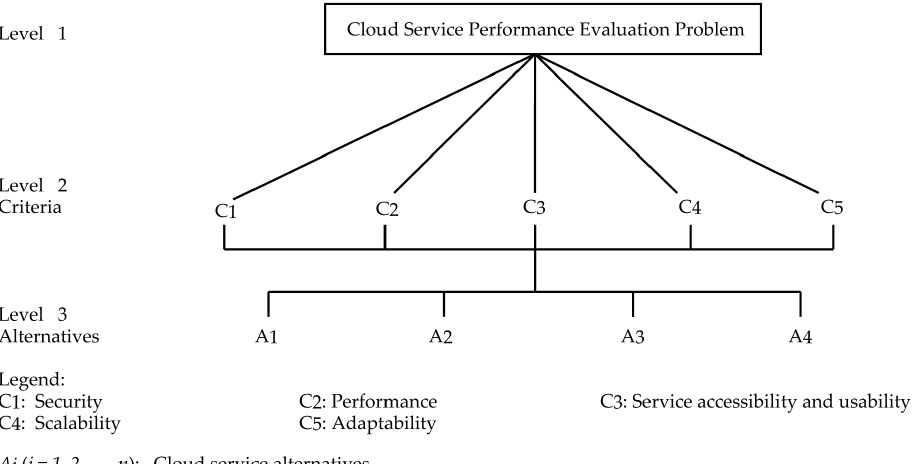
Figure 1. The hierarchical structure of the Cloud service performance evaluation problem.